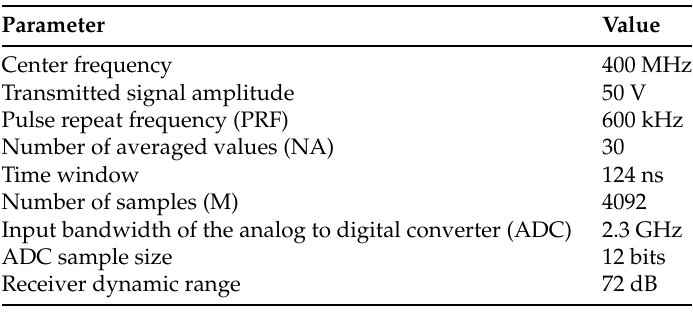
Table 1. Parameters of the UWB radar [94].